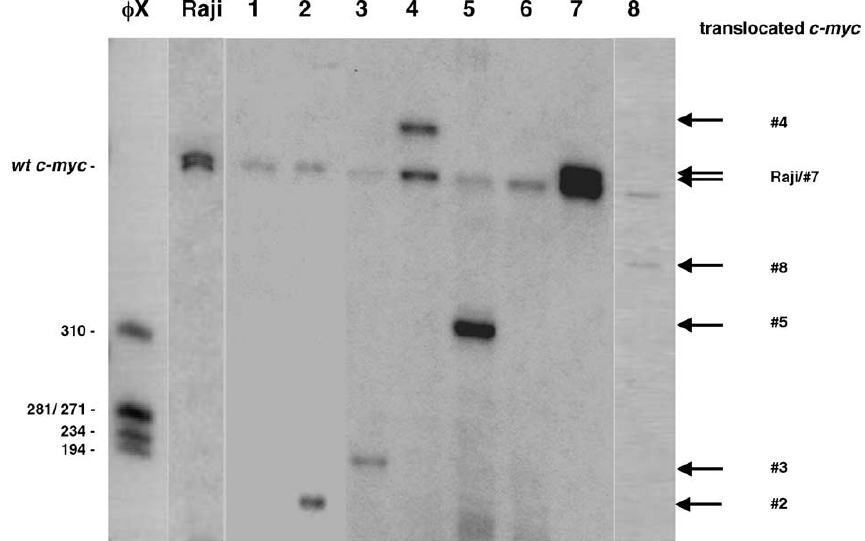
Fig. 2. LM-PCR based detection of c-myc translocations in Burkitt’s lymphomas. Raji shows amplification of 2 distinct bands, due to a 7-bp-deletion in the region between the MwoI-site and the gene specific oligos. For tumors 2, 3, 4, 5, 7, and 8, a second band was amplified in addition to the 377-bp band of the wild-type c-myc allele, indicating a translocation in this region. Φ x: Φ x 174 FR DNA/Hae III digest